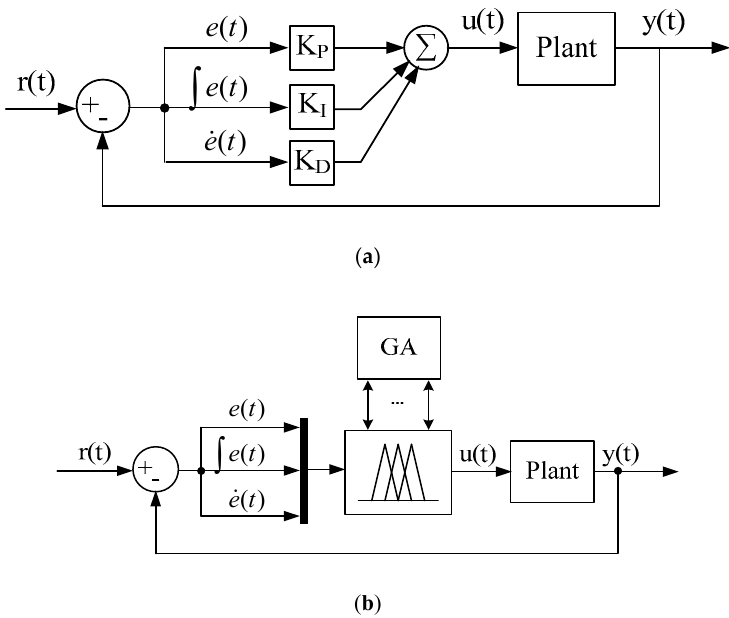
Figure 5. The unit feedback control structure: ( a ) PID control; and ( b ) optimal fuzzy PID control. Subsequently, we built the equivalent FLC for the above conventional PID controller